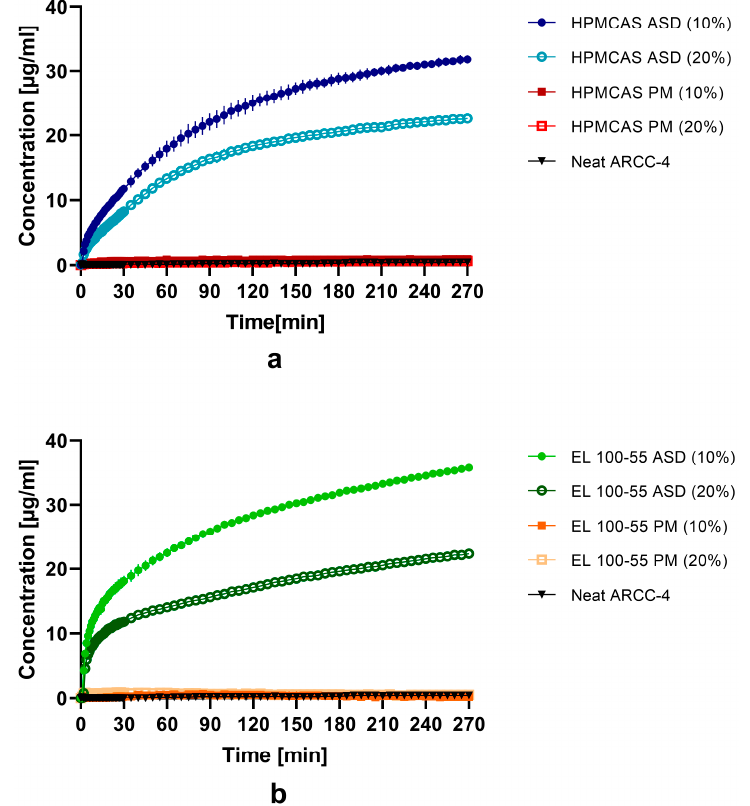
Figure 6. Dissolution profiles of ( a ) HPMCAS ASDs ( 10 and 20% drug load) compared to the corresponding PMs ( 10 and 20% drug content) and ▼ neat ARCC-4 and of ( b ) EL 100-55 ASDs ( 10 and 20% drug load) compared to the corresponding PMs ( 10 and 20% drug content) and ▼ neat ARCC-4. Non-sink dissolution study was conducted in 20 mL 0.05 M phosphate buffer at pH 6.8 (37 °C, 75 rpm paddle speed).